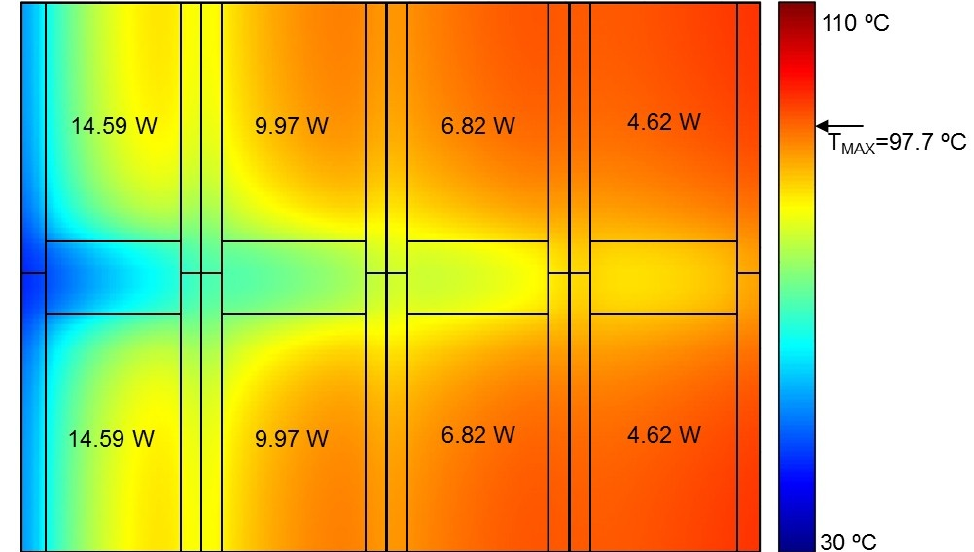
Figure 10. Temperature map of the middle layer of the simulated 3D processor where power dissipated in cores was calculated analytically (the quasi-optimal solution). The powers dissipated in other processor units are listed in Table 2. The inlets are located on the left side of the chip.